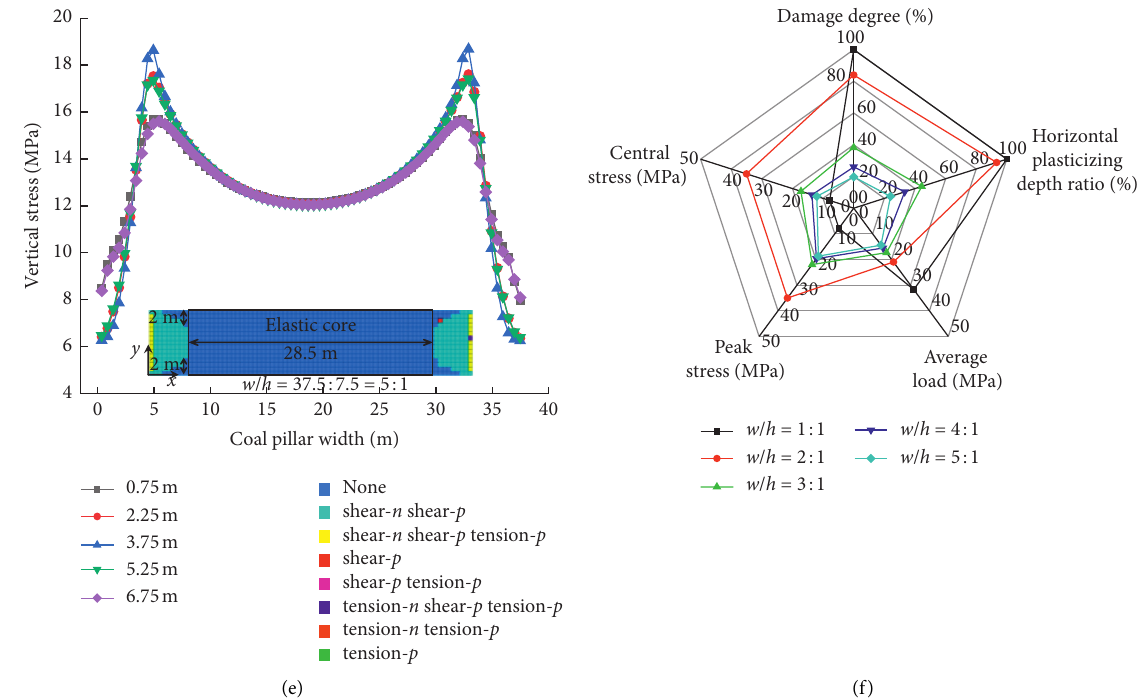
Figure 10: Stress and failure of the coal pillar with different aspect ratios. (a) Coal pillar aspect ratio of 1. (b) Coal pillar aspect ratio of 2. (c) Coal pillar aspect ratio of 3. (d) Coal pillar aspect ratio of 4. (e) Coal pillar aspect ratio of 5. (f) Multivariate analysis.